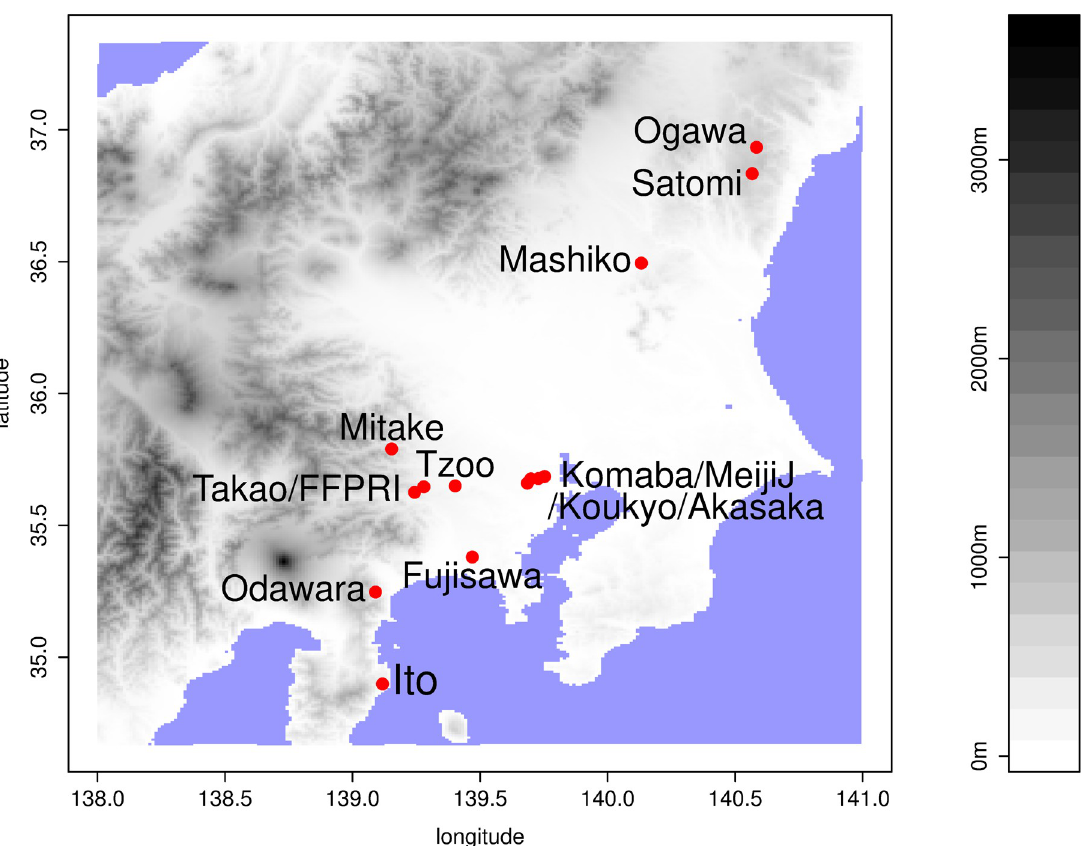
Fig 1. Locations of Ito and the other 13 sampling sites in Kanto. See Table 1 for a detailed description of the